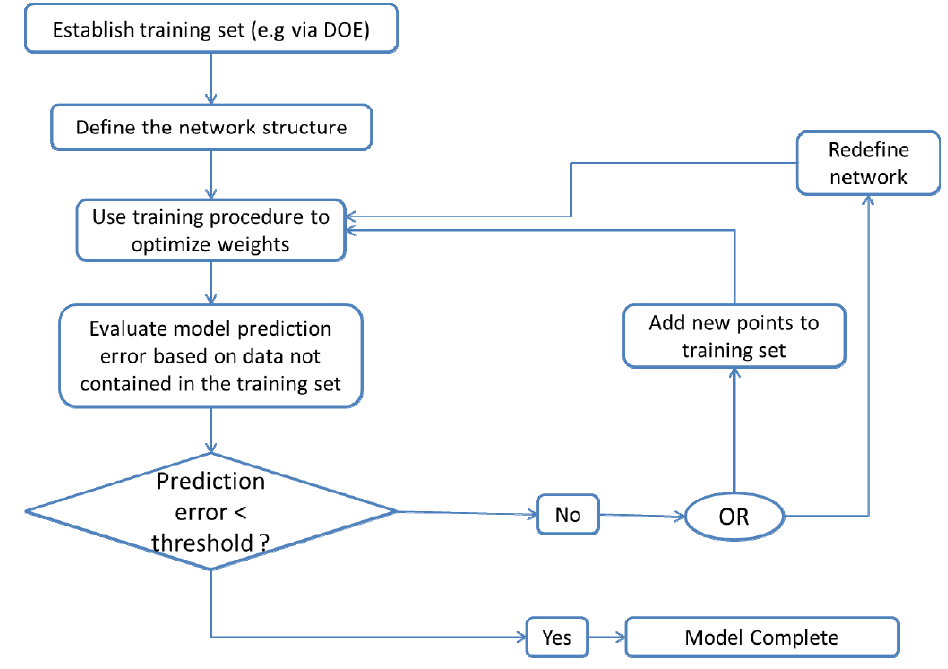
Figure 6. Algorithm for development of an Artificial Neural Network with the option to add points to the training set or to redefine the network structure in order to improve model predictive